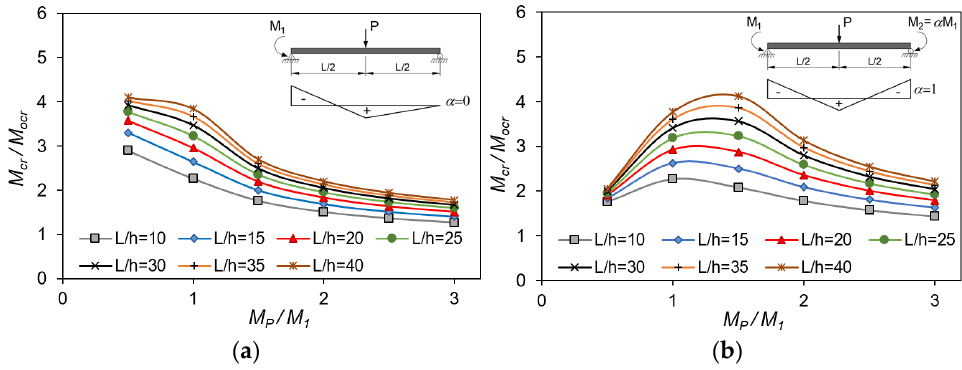
Figure 8. Finite element analysis results for LC 2 . ( a ) α = 0. ( b ) α = 1.